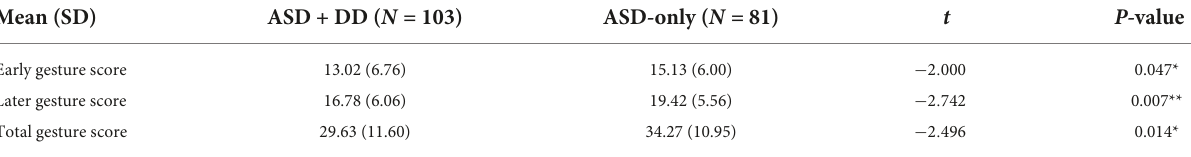
TABLE 2 Comparisons of gesture development between autism spectrum disorder patients with and without gesell developmental diagnosis scale. Mean